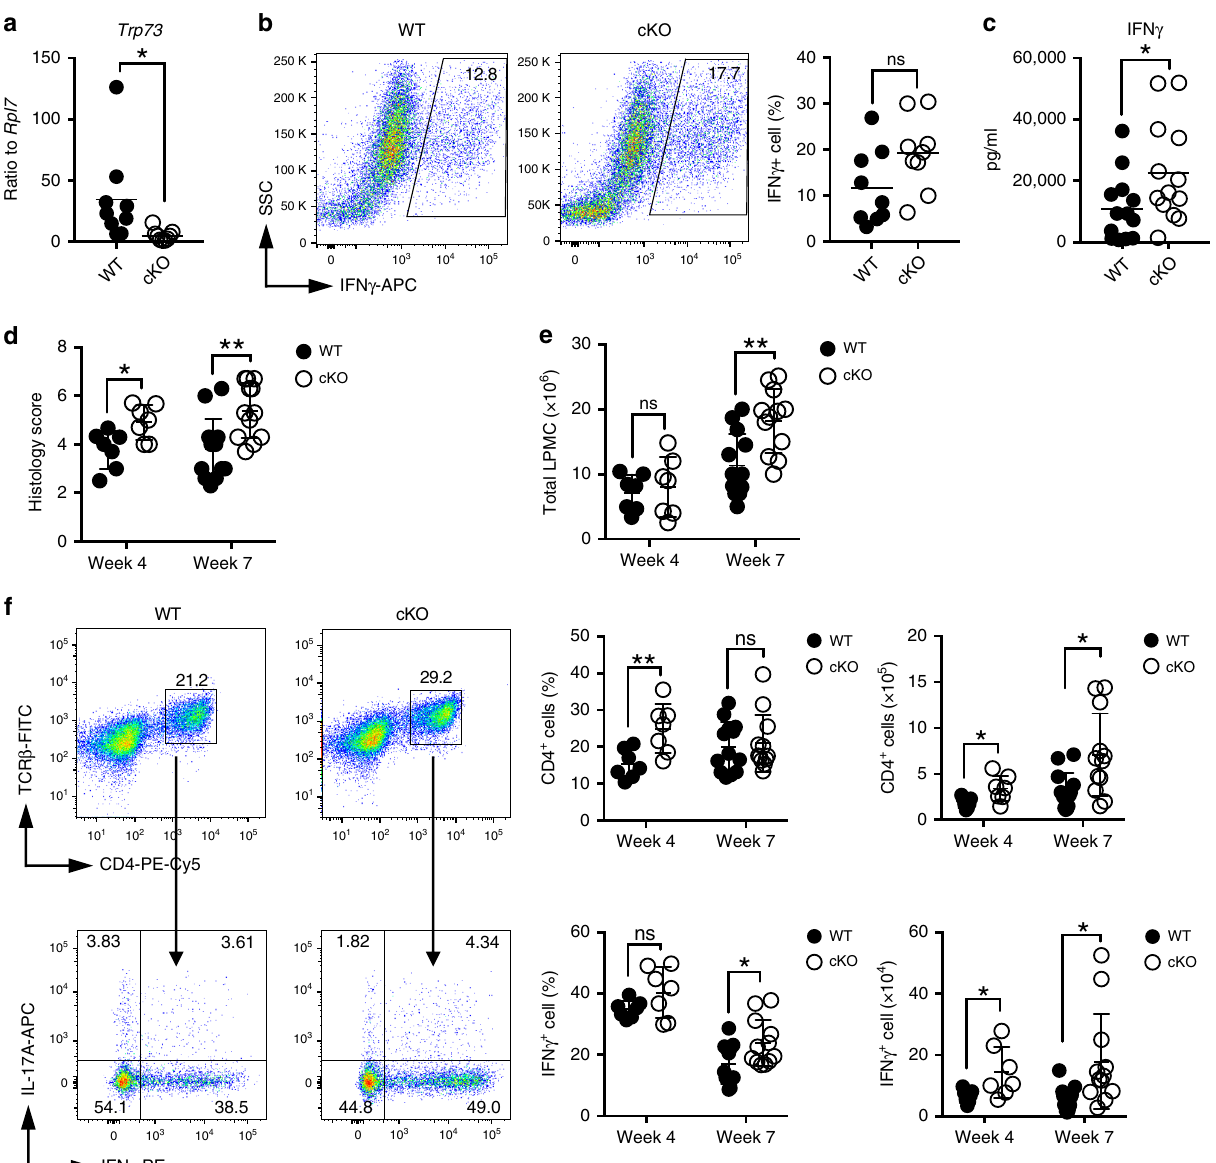
Fig. 7 Augmented IFN γ production following in vitro differentiation and enhanced pathogenic IFN γ -producing T cell induction and disease mediated by Trp73 -de fi cient T cells in an adoptive T cell transfer model of colitis. a – c Naive CD4 + cells from WT and Trp73 conditional knockout (cKO) mice were differentiated into Th1 cells for 2 days. a mRNA expression of Trp73 were assessed by qRT-PCR. Data are pooled results from two independent experiments with n = 9 mice per group in total. b Intracellular IFN γ levels were measured by fl ow cytometric staining; a representative FACS plot is shown on the left and summarized IFN γ expression data are shown on the right. c Secreted IFN γ levels (right panel) were measured by LEGENDplex TM assay. Data for b , c are pooled results from three independent experiments with n = 13 mice per group in total. All data from a – c are presented as scatter dot plots with mean value indicated and P values were calculated using mean ± SEM by two-tailed unpaired Student ’ s t test. d – f CD4 + CD45RB hi T cells from WT or Trp73 cKO mice were adoptively transferred into Rag2 − / − recipients to induce colitis. Colonic histology scores at weeks 4 and 7 post-transfer are shown in d . Total colonic lamina propria mononuclear cell (LPMC) counts from the indicated time points are shown in e . f In fi ltrating CD4 + T cells in the colon were measured by fl ow cytometry and the percentage and number of CD4 + T cells are shown. IFN γ -producing CD4 + T cells in the colon were determined by intracellular staining, and the percentage and number of IFN γ + CD4 + T cells are indicated. Data for d – f are combined from two experiments with 9 – 10 mice per group in each experiment. In total, n = 7 mice per group were analyzed at week 4, and n = 13 (WT) and n = 12 ( Trp73 cKO) mice per group were analyzed at week 7. All data from d – f are presented as scatter dot plots with mean ± SD indicated and analyzed by two-tailed unpaired Student ’ s t test with Welch ’ s correction, and the P values are indicated (ns P ≥ 0.05; * P < 0.05; ** P < 0.01). Source data for a – f are provided in Source Data